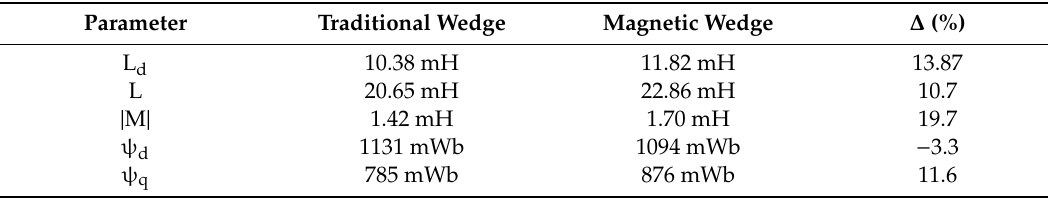
Table 4. Mean values of inductances and flux linkage at full load. Figure 14. ( a ) Self-inductance of phase 1 at full load; ( b ) Absolute value of mutual inductance between phase 1 and 2 at full load.